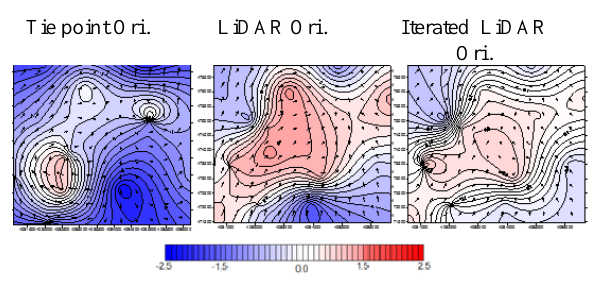
Figure 13. 2008 Check Points Analyse Studying discrepancies in planimetric coordinates, the point errors evolves from 1.733 m in the tie point orientation phase